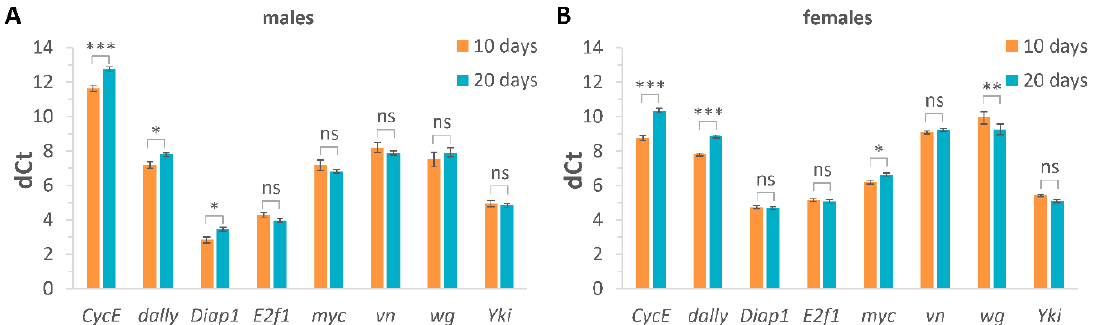
Figure 1. Age-related changes in the expression level of Yki target genes. Estimation of the expression level in males ( A ) and females ( B ) at the age of 10 and 20 days. Two-way ANOVA (age × gene) followed by post hoc Duncan test was used to compare differences in expression levels of genes between 10-day-old and 20-day-old flies, * p < 0.05, ** p < 0.01, *** p < 0.001, ns—not significant. The Ct (cycle thresholds) values are inversely proportional to the mRNA transcript levels. The delta Ct (dCt) values were calculated as the differences in Ct values for target genes and reference genes ( β -Tubulin and RpL32 ). Higher dCt values represent a lower expression level. The error bars show standard errors. The experiments were performed in three biological replicates and three technical replicates ( n = 3, repeated three times). The samples included 20 males and 10 females.